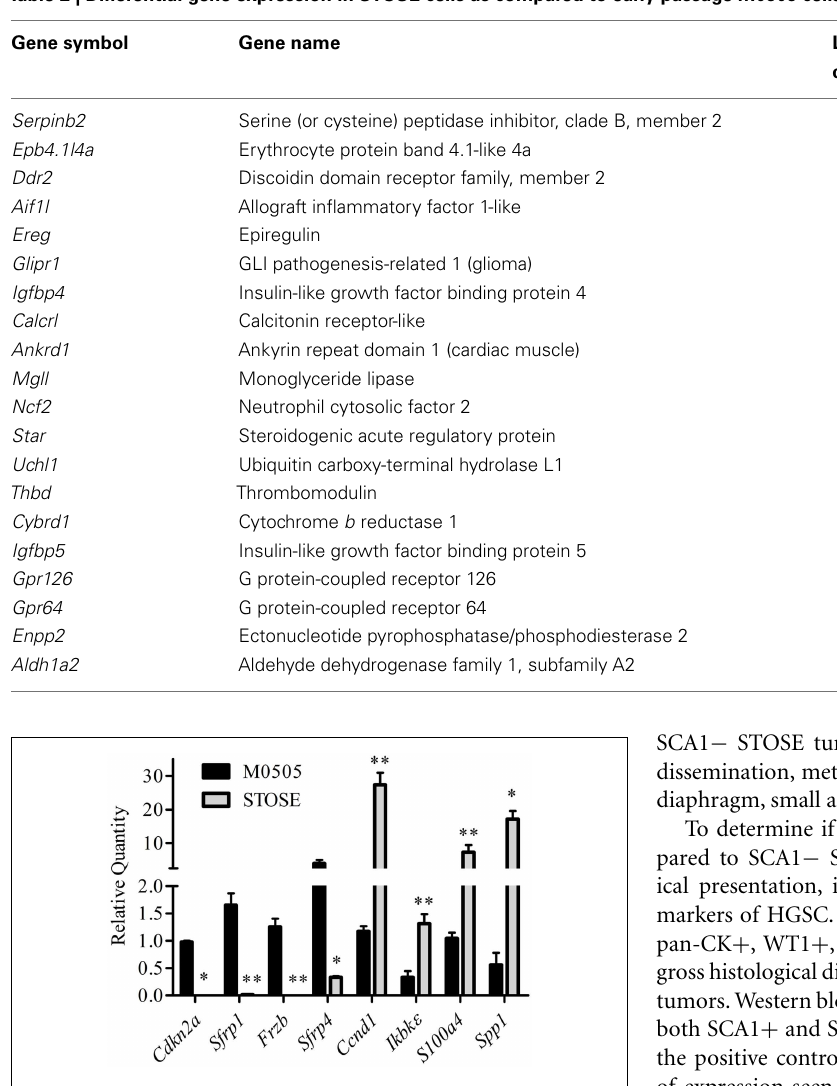
FIGURE 3 |Validation of genes differentially expressed in STOSE cells related toWnt/ β -catenin and Nf- κ B signaling or in common withTCGA ovarian carcinoma arrays. Quantitative RT-PCR analysis for Cdkn2a, Sfrp1, Frzb, Sfrp4, Ccnd1, Ikbk ε , S100a4, and Spp1 expression is presented for M0505 and STOSE cells ( n = 3). Samples used for validation are independent of those used for microarray analysis. Error bars represent SEM and * p < 0.05, ** p < 0.01 by Student’s t